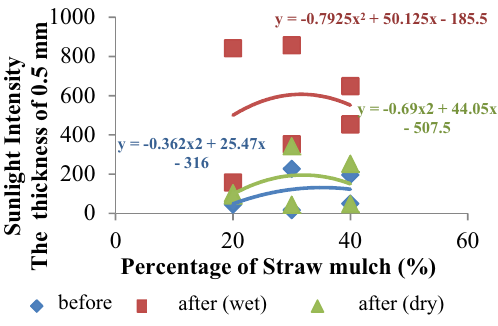
Fig. 7 The correlation between sunlight intensity and the percentage of banana pseudostem in 0.5 mm organic mulch sheet